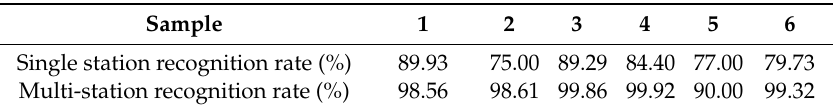
Table 4. Recognition rate of terrestrial laser scanning.